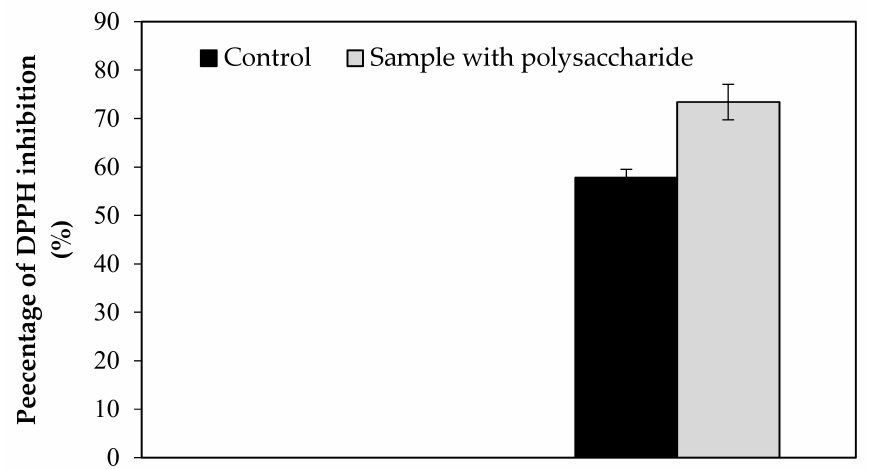
Figure A1. Effect of KWSP on